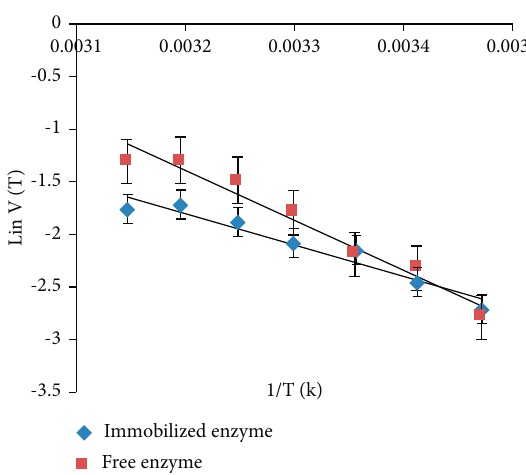
Figure 3: The thermodynamic curve of free urease immobilized urease